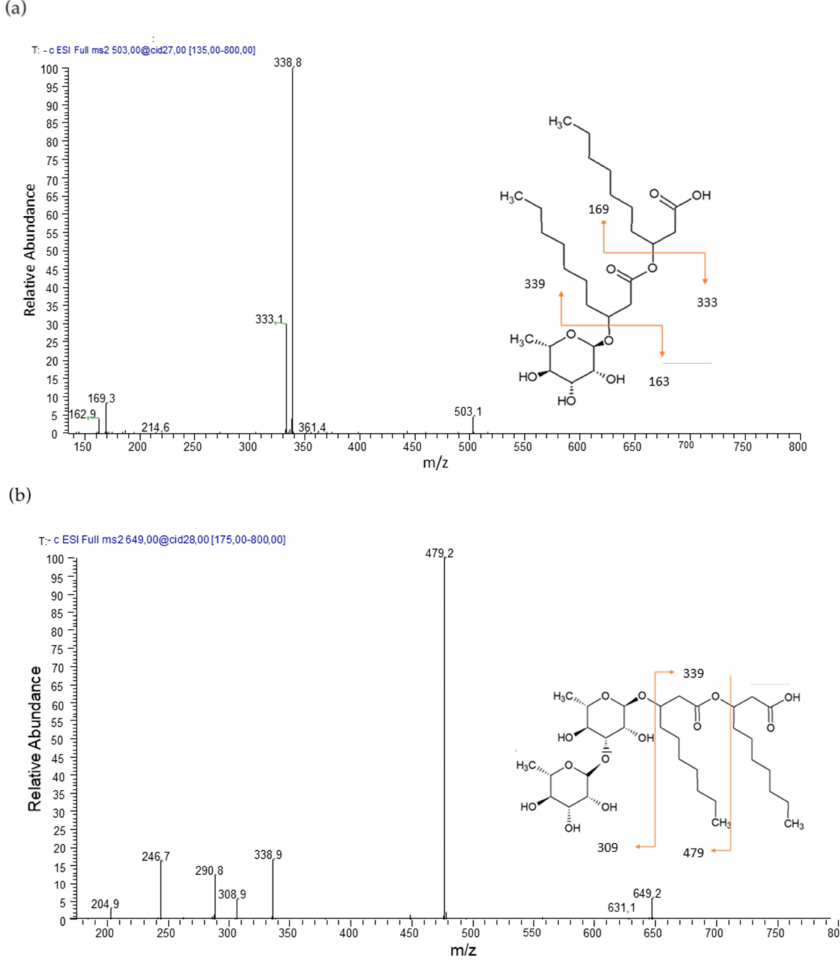
Figure 2. Product ion spectra and proposed fragmentation of ( a ) m/z 503 [M–H] − of Rha-C10-C10 and ( b ) m/z 649 [M–H] − of